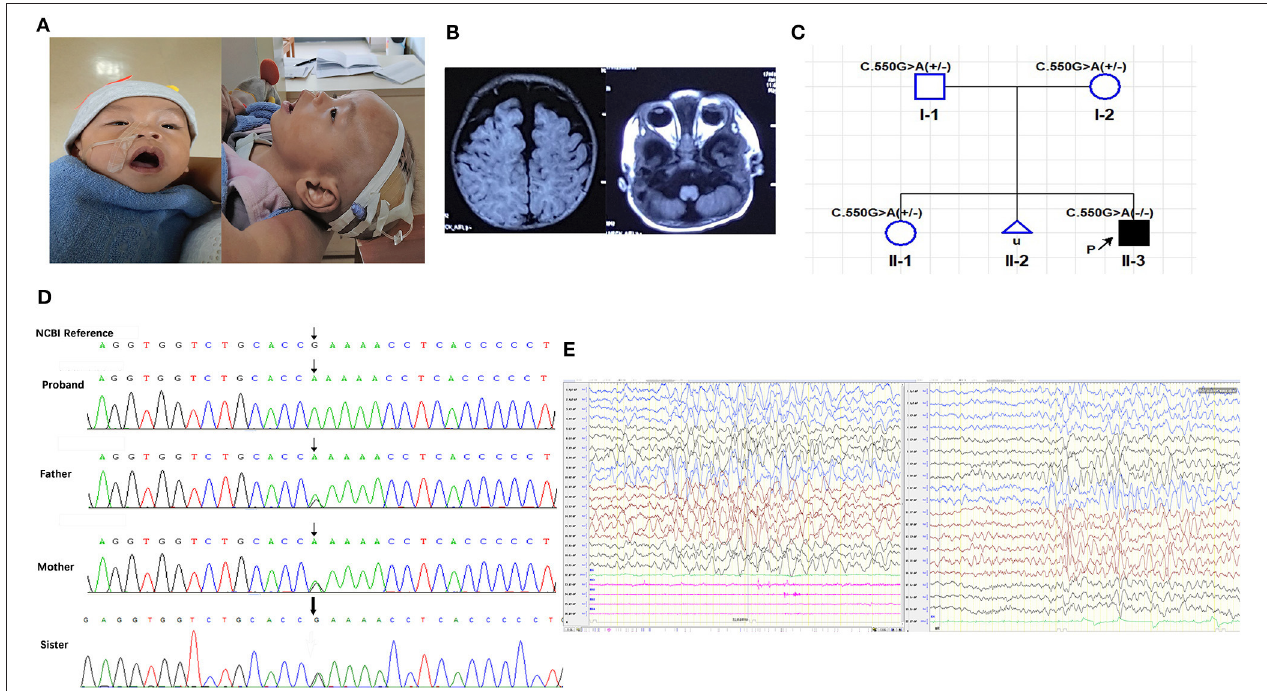
FIGURE 1 | (A) Photographs taken at 10 months-old; (B) T1 weighted cranial magnetic resonance imaging; (C) Family pedigree of segregation of the PIGT c.550G > A; (D) Sanger sequencing of the proband and his parents and old sister; (E) EEG of the proband at 10 months-old. (A) Shown the high forehead with frontal bossing, narrow bitemporal, depressed nasal bridge, tented lip, wide and opening mouth, high arched palate, low ear set of the proband. (B) Widen subarachnoid and cerebellar atrophy especially in vermis. (C) The PIGT c.550G > A segregated with the clinical syndrome, in which the proband is homozygous recessive and his asymptomatic parents and healthy old sister are heterozygous; (D) Chromatograms of the Sanger sequencing, showing the homozygous PIGT c.550G > A variant in the proband and heterozygous variants in his parents and old sister. (E) (Left) Frequent myoclonia on the waking stage; (Right) Numerous of slow waves and slow-spike waves in bilateral hemisphere, especially in posterior